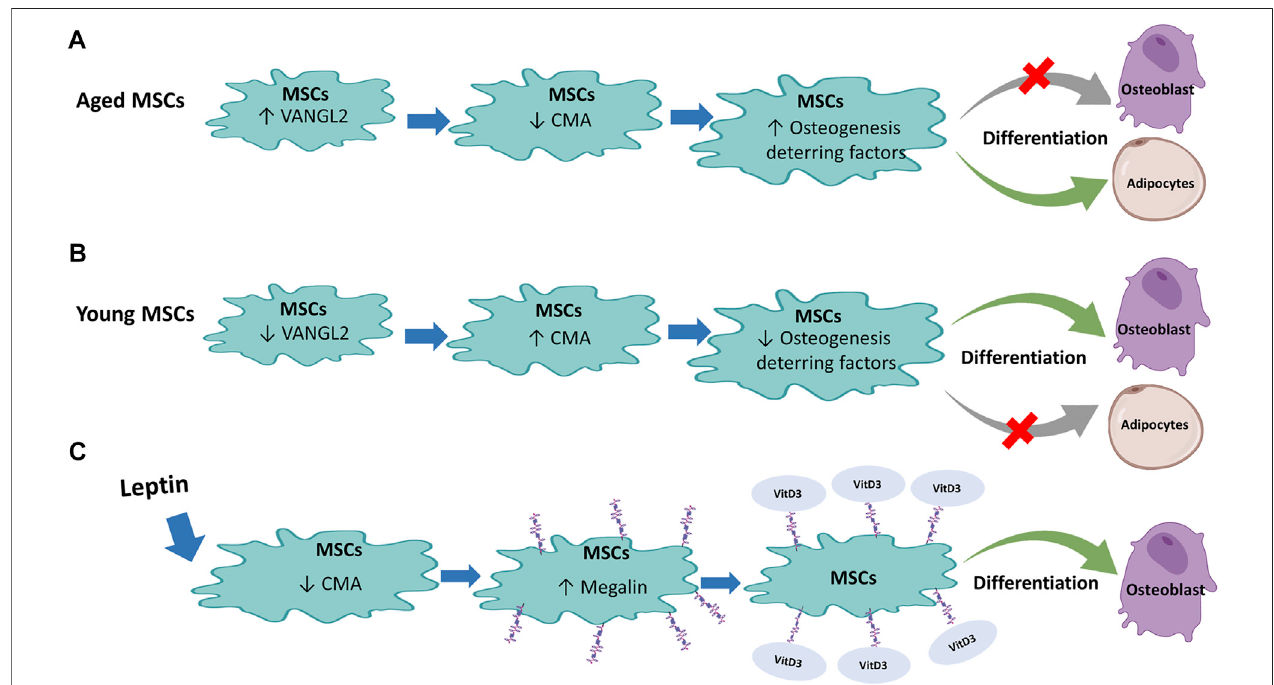
FIGURE5| Regulation ofMesenchymalstemcells(MSCs) byChaperone-Mediated Autophagy(CMA): (A) InagedMSCs,activeVANGL2protein decreases CMA with consequent enhancement of osteogenesis-deterring factor level that inhibits osteoblast differentiation and encourages differentiation of MSCs into adipocytes. (B) The opposite effect occurs in young MSCs where the low level of VANGL2 and increased CMA induce osteogenesis-deterring factors reduction. This promotes MSC differentiation into osteoblasts and reduce adipocyte differentiation. (C) Leptin treatment in rat MSCsdecreases CMA that inturn inhibits degradation of megalin, a receptor for vitamin D3. Binding of vitamin D3 to its receptor promotes differentiation of MSCs into osteoblasts.